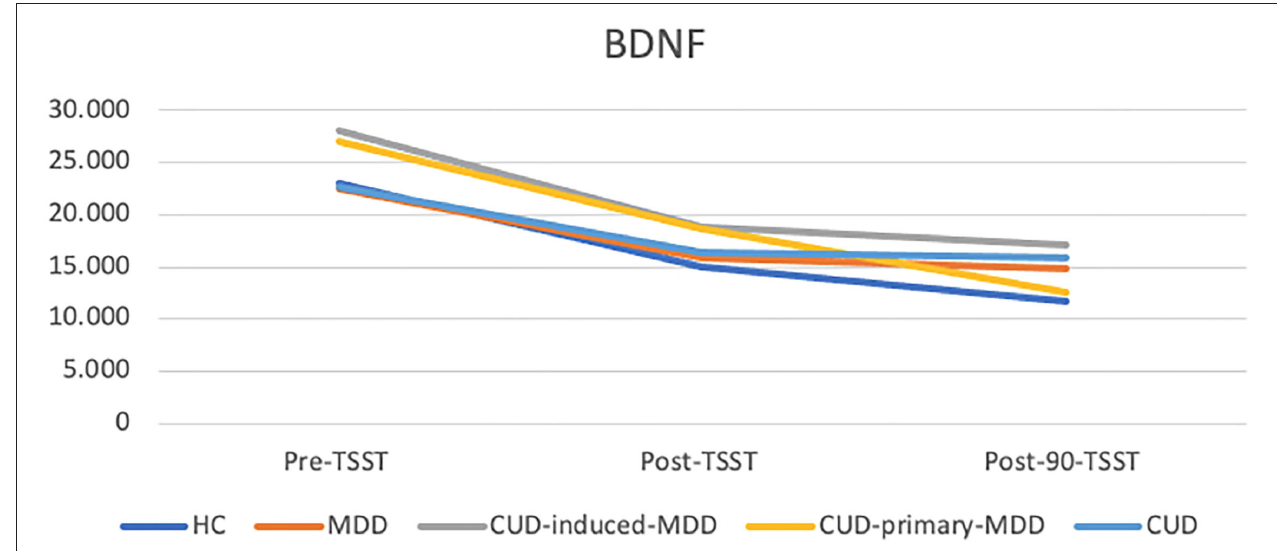
FIGURE 2 | Mean BDNF concentrations during Trier social stress test (TSST). HC, healthy control ( n = 21); MDD, major depression disorder ( n = 6); CUD, cocaine use disorder ( n = 15), CUD-primary-MDD, ( n = 16), CUD-induced-MDD ( n =